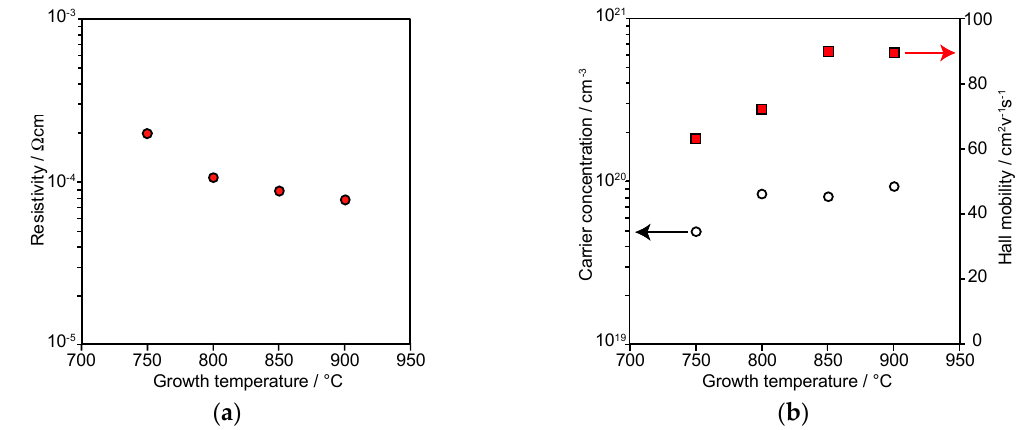
Figure 6. Growth temperature dependence of ( a ) resistivity, ( b ) carrier concentration, and Hall mobility of the ScN film. The red circles indicate resistivity. The open circles denote the carrier concentration. The red squares depict the Hall mobility of the films. The Sc source temperature is set to 1300 °C. The film thicknesses are in the range of 140–175 nm.